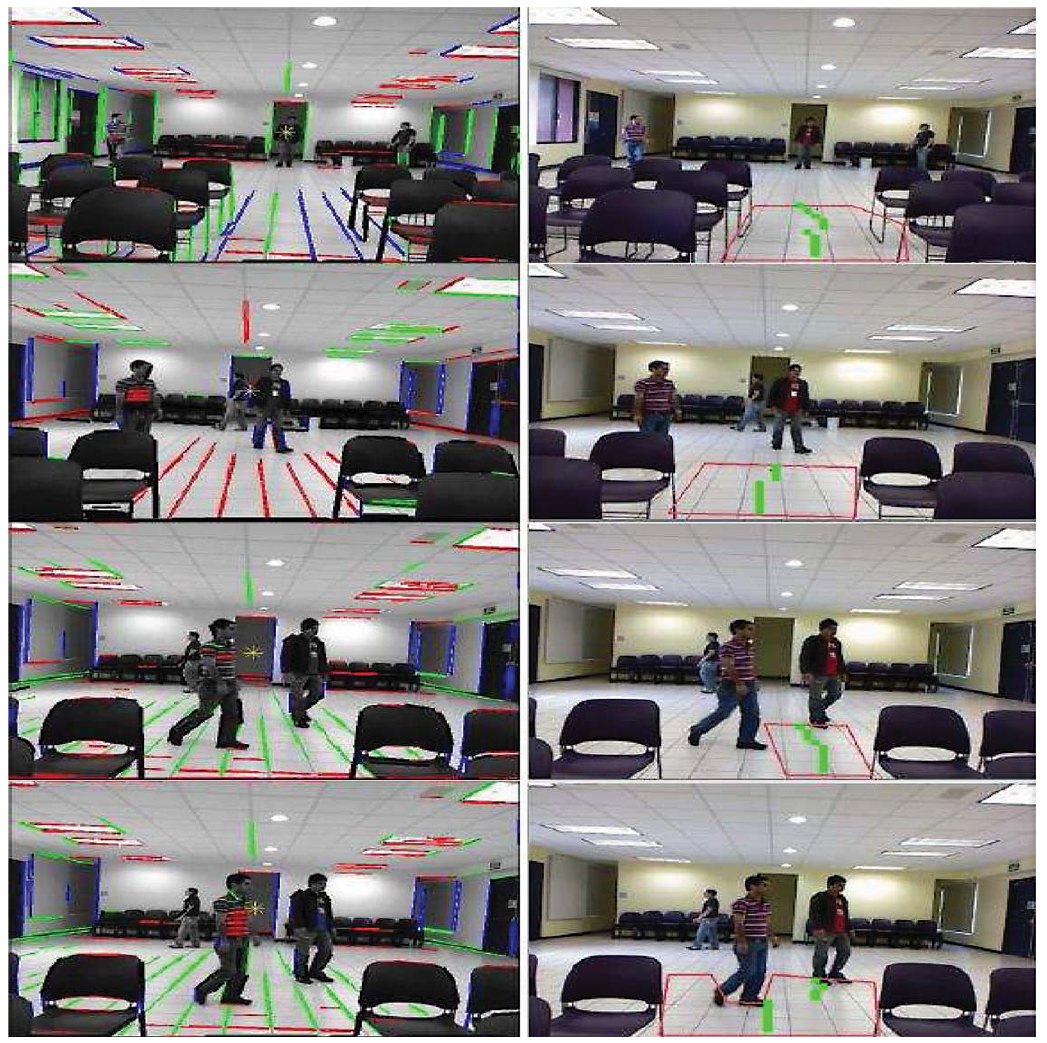
Fig. 19. Navigation path avoiding obstacles and walking persons: a succession of paths generated by the inference engine processing in real time using the stereo data, vanishing points, and the person and obstacle’s location on the floor map.